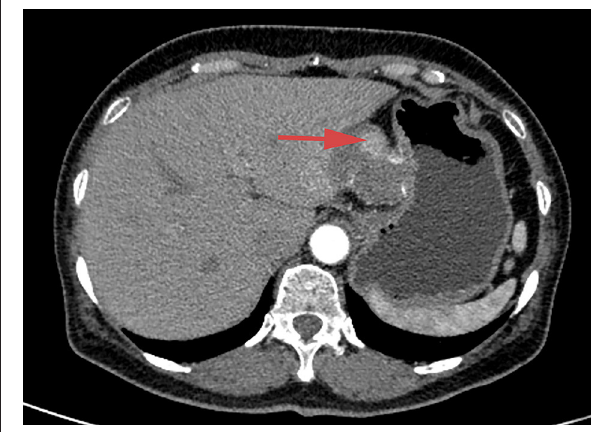
FIGURE 1 | Space occupying lesion, measuring about 6 × 5cm, in the patient’s abdomen.